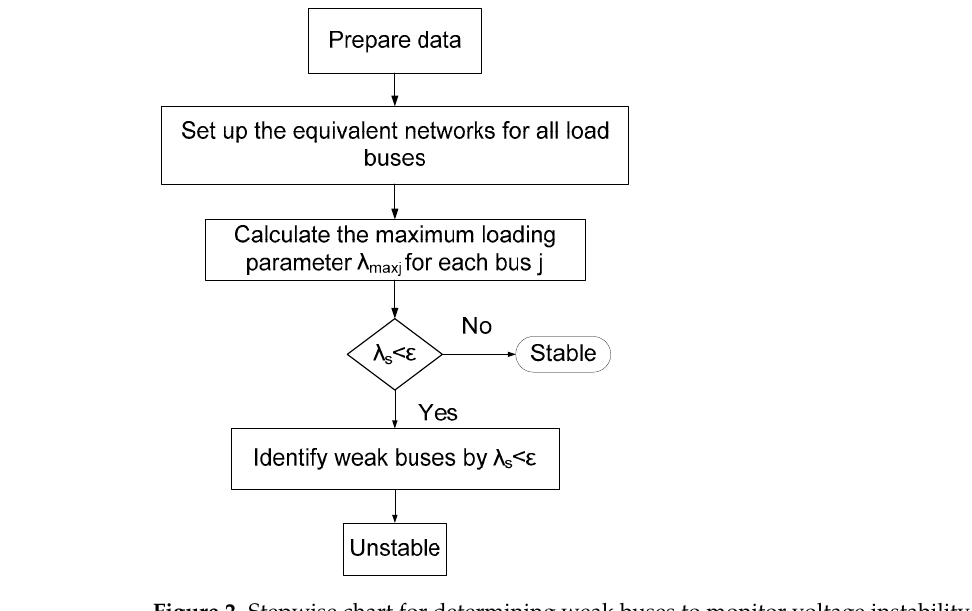
Figure 2. Stepwise chart for determining weak buses to monitor voltage instability.